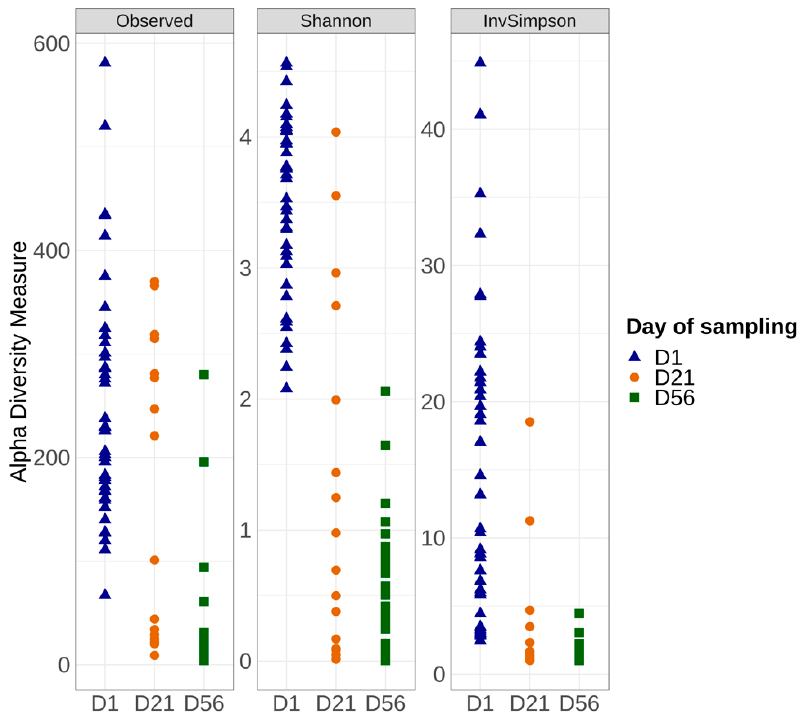
Figure 3. Alpha diversity measures among the control samples at day 1, 21, and 56 using Observed, Shannon, and Inverse Simpson indices.